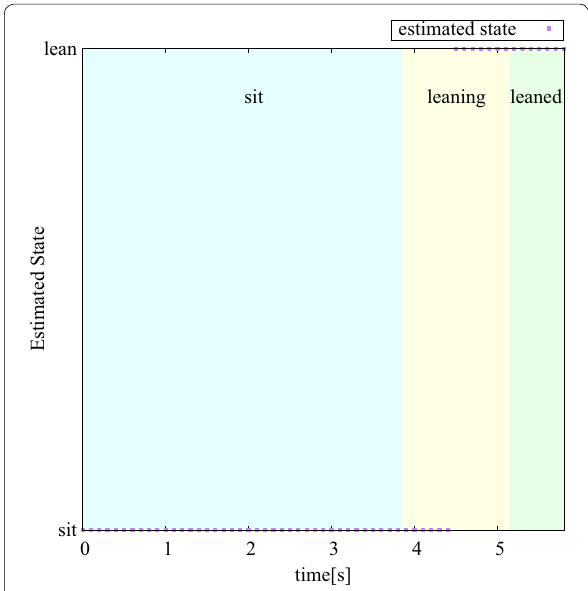
Fig. 8 Time variation of estimated state (participant J.) Background colors represent the actual state. Blue: sitting; yellow: leaning; green: leaned. The purple points indicate the estimated